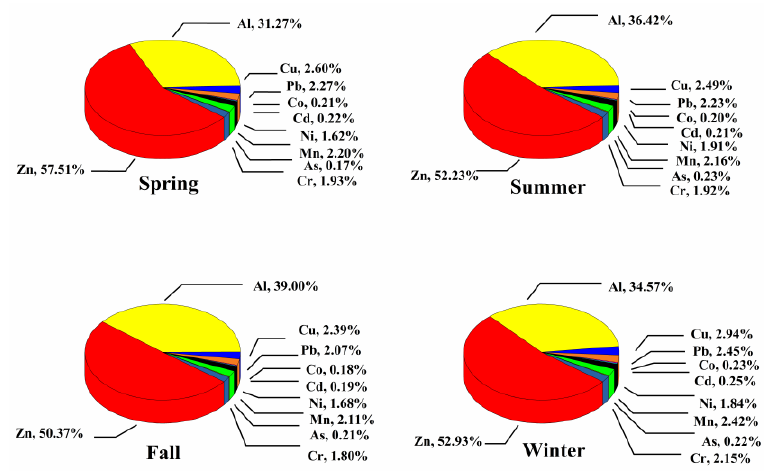
Figure 4. Relative percentages of each heavy metal to all heavy metals